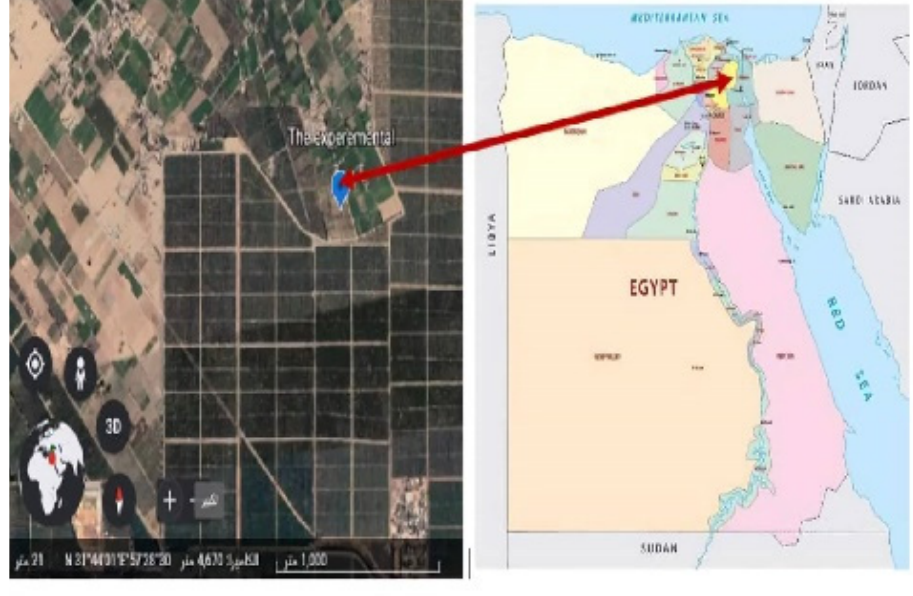
Figure 1. GPS location of the experiment.